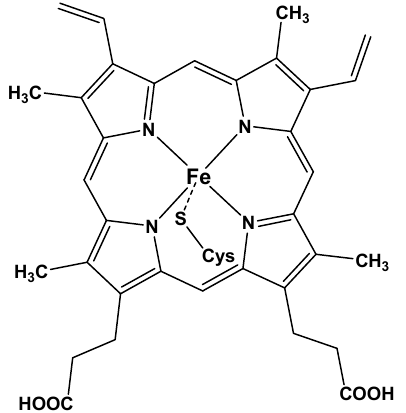
Figure 1. Schematic representation of the prosthetic group of the cysteinate-heme enzyme cytochrome